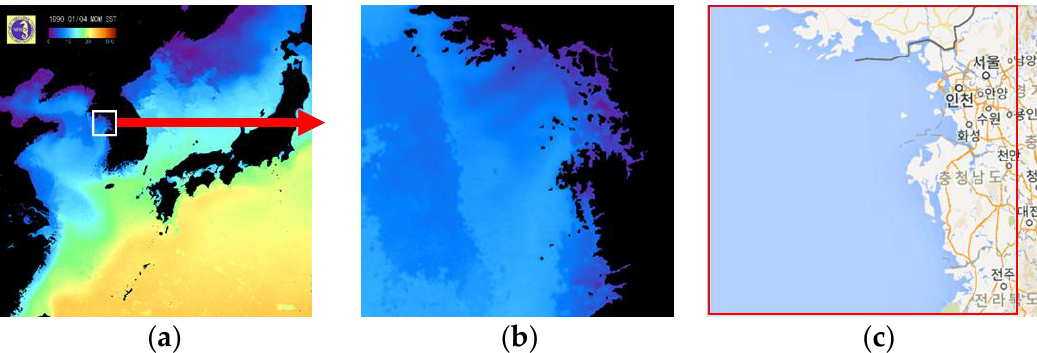
Figure 5. Example image used to train and test our deep network model. ( a ) 256 × 256 pixel region (white box) was cropped from each collected SST image of 2000 × 2000 pixels, ( b ) enlarged cropped image for better visualization, ( c ) cropped region is shown on a map. Table 1. Number of training and test images used to construct a deep network model (i.e., GIN) in each month.